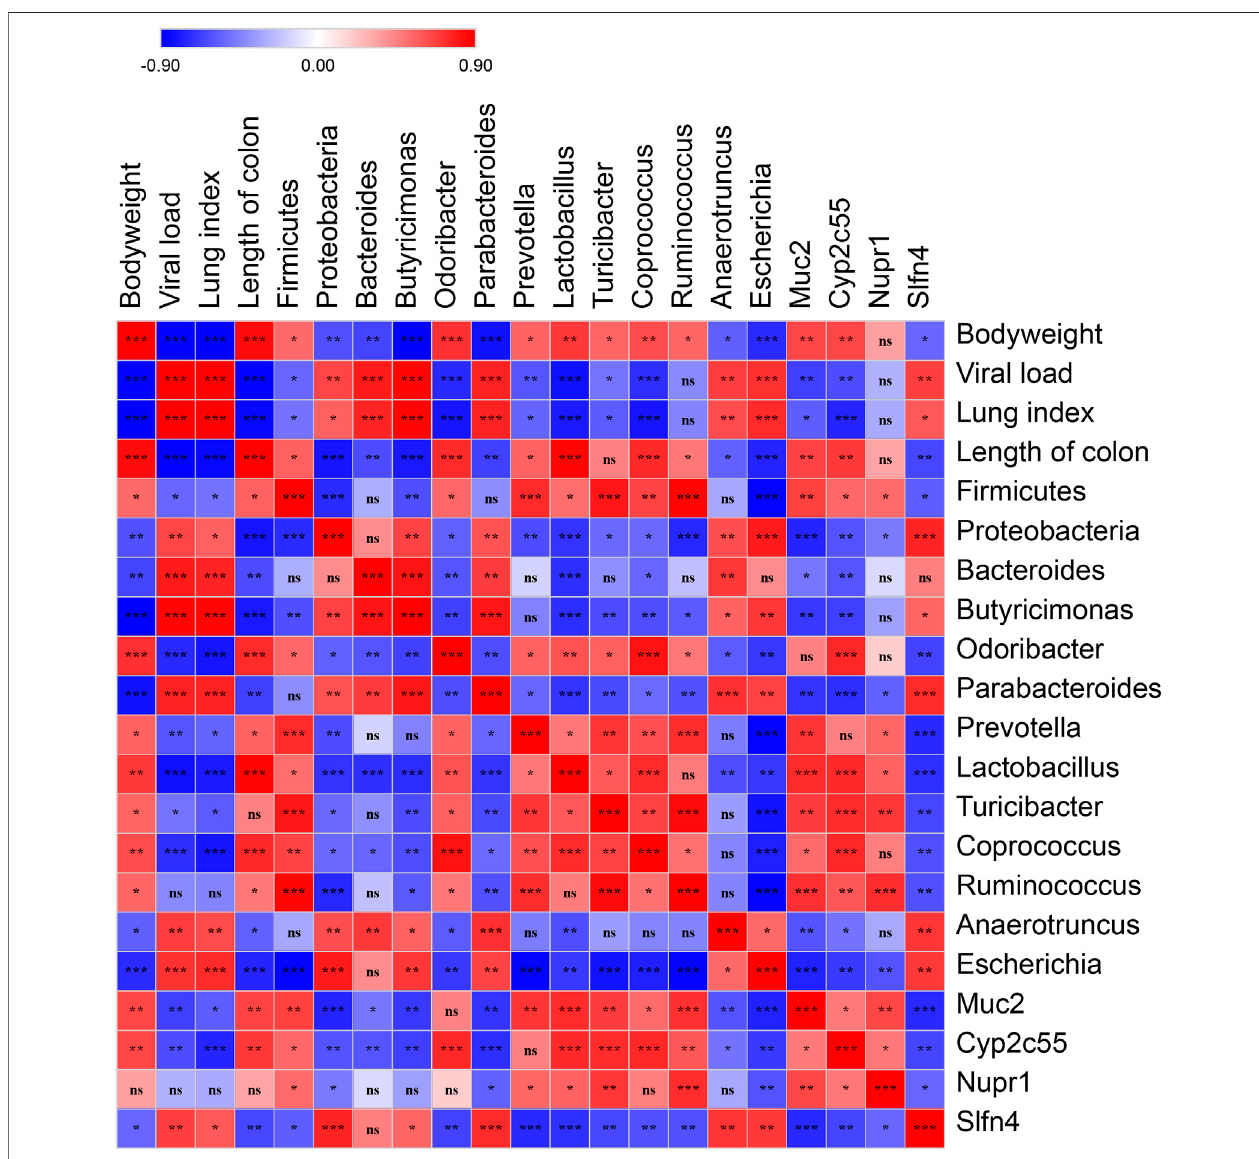
FIGURE 8 | Spearman ’ s correlation graph of bodyweight, viral load, the differential OTUs, and the differential genes. The R values are denoted with graduated colors, and the red and blue grids indicated positive and negative correlations, respectively. ( “ ns ” indicates non-signi fi cance; * p < 0.05, ** p < 0.01, *** p < 0.001).